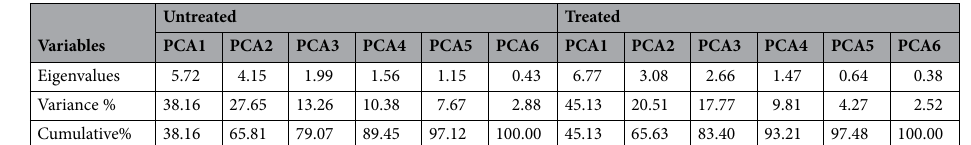
Table 1. Results of PCA in the first six PCAs for the studied variables during untreated and treated palm date